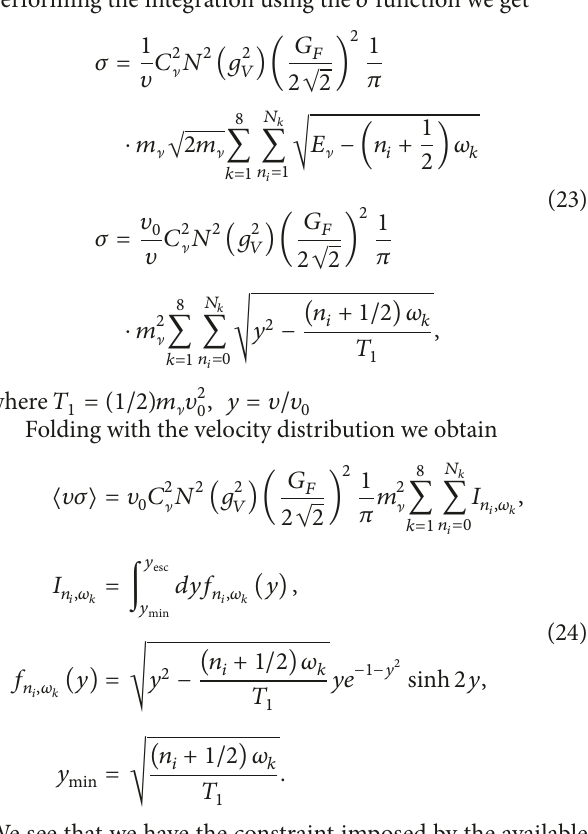
Figure2:(a)Thefunction 𝑓 𝑛,𝜔 (b) The functions 𝑓 𝑛,𝜔 exhibited as a function of 𝑦 , for thick solid, solid, dashed, and dotted lines, respectively. For definitions see text.